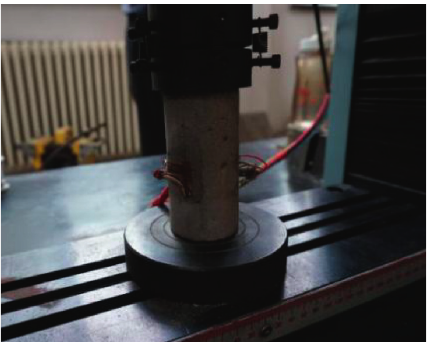
Figure 4: Uniaxial loading test.